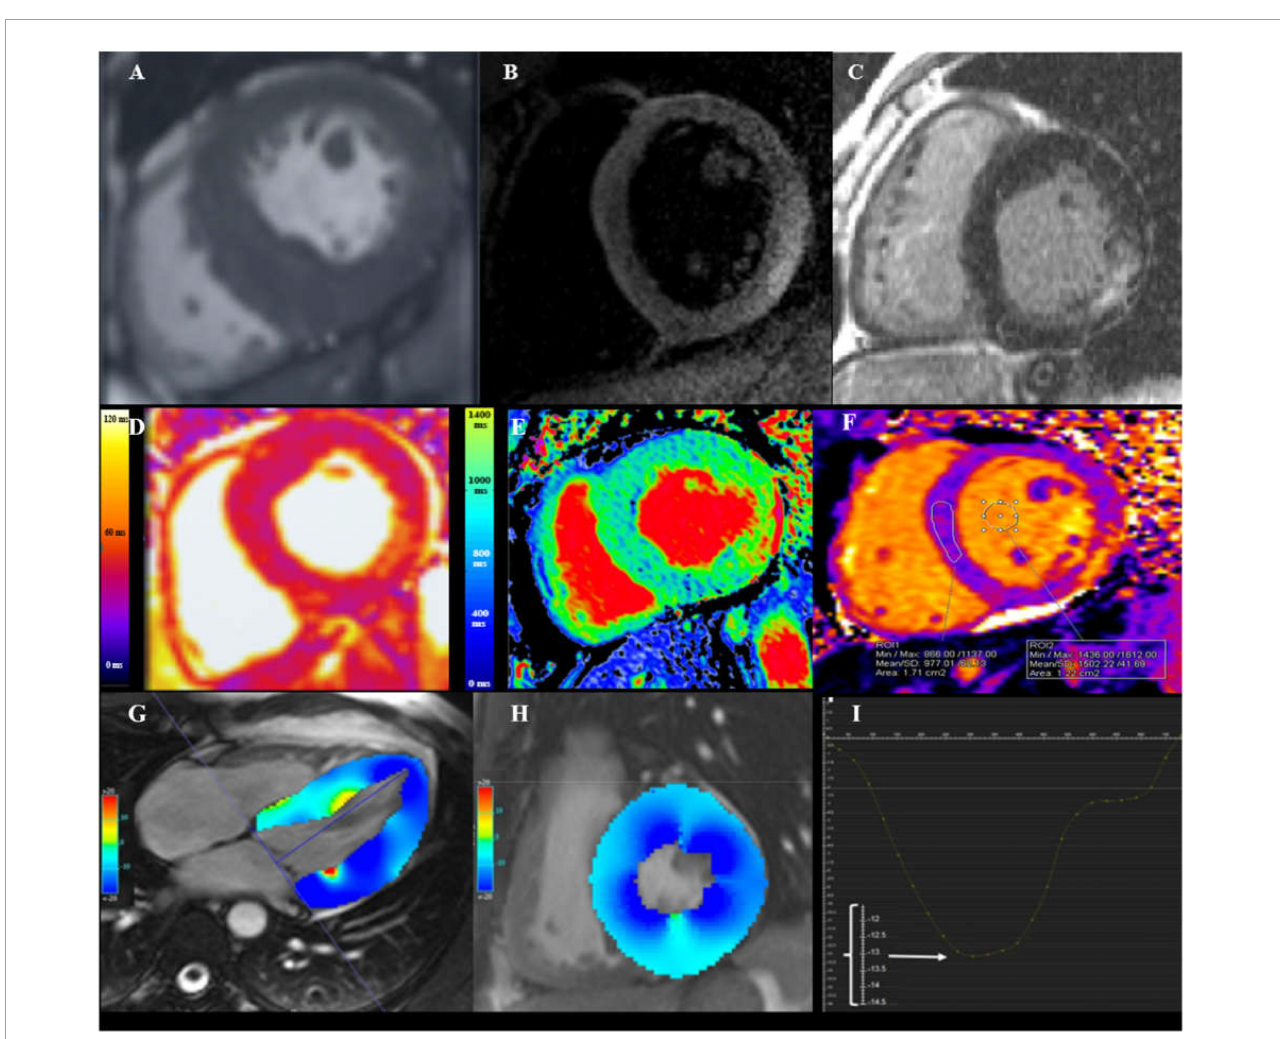
FIGURE1 Cardiovascular magnetic resonance (CMR) assessment in Fabry disease (FD). (A) Steady state free precession (SSFP) CINE short-axis view showing increased wall thickness of mid-inferoseptum measuring 22 mm. (B) Dark-blood T2 short inversion-time, inversion-recovery (STIR) image showing myocardial edema (arrowheads) in the basal inferolateral wall (BIFL). (C) Late gadolinium enhancement (LGE) imaging showing mid-myocardium BIFL LGE in short-axis view. (D) Native T2 mapping showing high myocardial T2 value in BIFL (54 ms; normal reference value 45 ± 2 ms for this 1.5 T scanner). (E) Native T1 mapping showing low myocardial T1 value in the septum (812 ms; normal reference value 984 ± 18 ms for this 1.5 T scanner). (F) Native T1 mapping in advance disease showing pseudonormalization of T1 value in the septum and increased T1 in the BIFL. (G) Long-axis CINE SSFP image with color-coded myocardial longitudinal strain map. (H) Short-axis CINE SSFP image with color-coded myocardial circumferential strain map. (I) Decreased global longitudinal strain of − 13.2%, as the enlarged scale on the Y -axis showed [adapted from Roller et al.